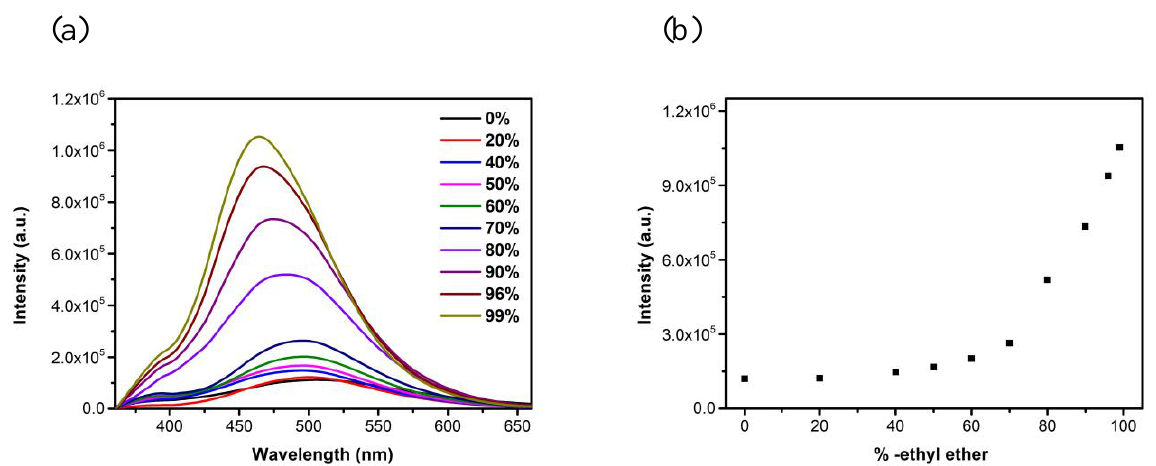
Figure 5. ( a ) Fluorescence emission spectra of ligand LA in varying proportions of chloroform–ethyl ether solvent mixture; ( b ) Fluorescence intensity of ligand LA at 340 nm in the varying proportions of chloroform – ethyl ether solvent mixture (c = 1.0 × 10 − 6 M, λ ex = 340 nm, Slit = 3, 3).